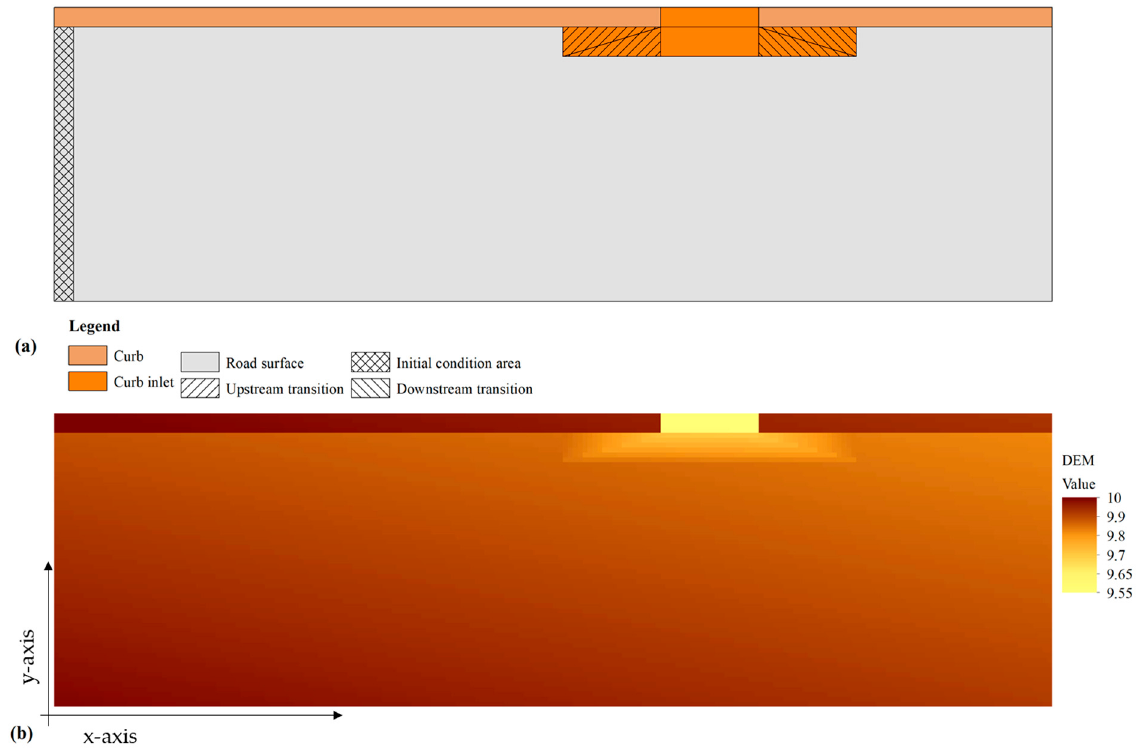
Figure 3. ( a ) Layout of type C curb inlet evaluation experiment (top view), and ( b ) DEM of case C01 with a longitudinal slope, S 0 = 0.004, and cross slope, S x = 0.0208.